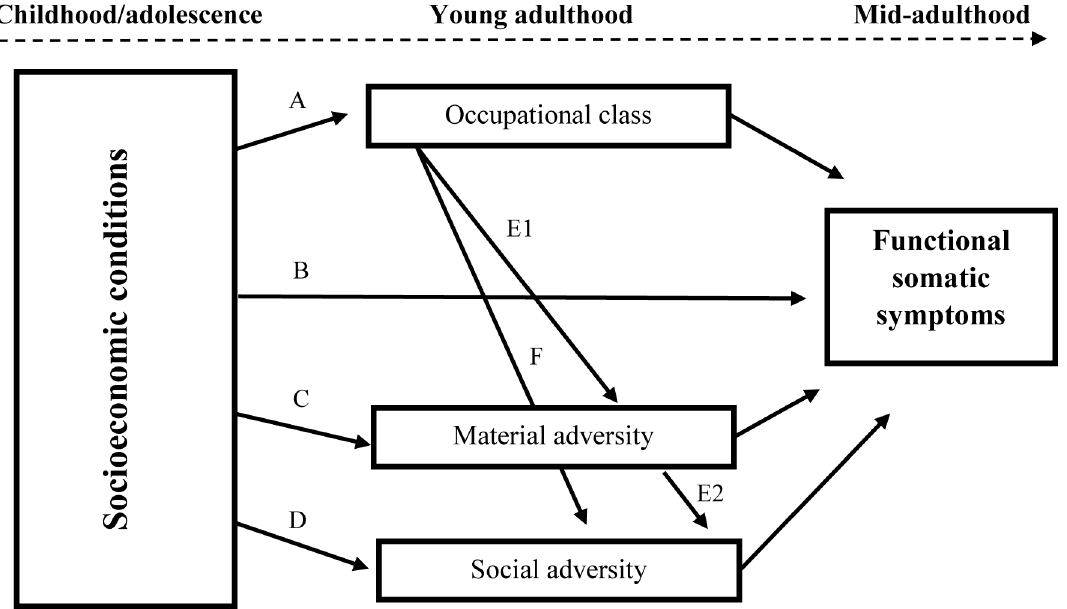
Fig 1. Conceptual model of adversity pathways in the association between socioeconomic circumstances early in life and functional somatic symptoms in adulthood.